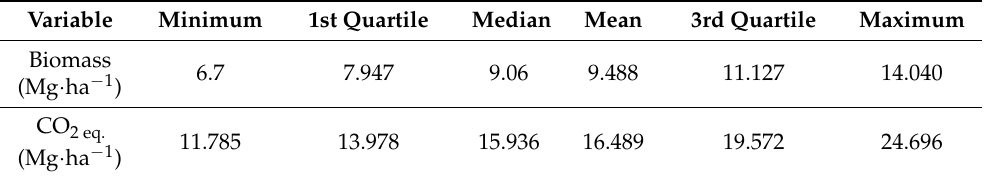
Figure 2. Biomass sampling of Quercus pyrenaica Willd. in Chequilla (Mg · ha − 1 ), 2020. Table 2. Statistics of the shrub biomass values (Mg · ha − 1 ) and its corresponding CO 2 equivalent (Mg · ha − 1 ) for the Chequilla study area.